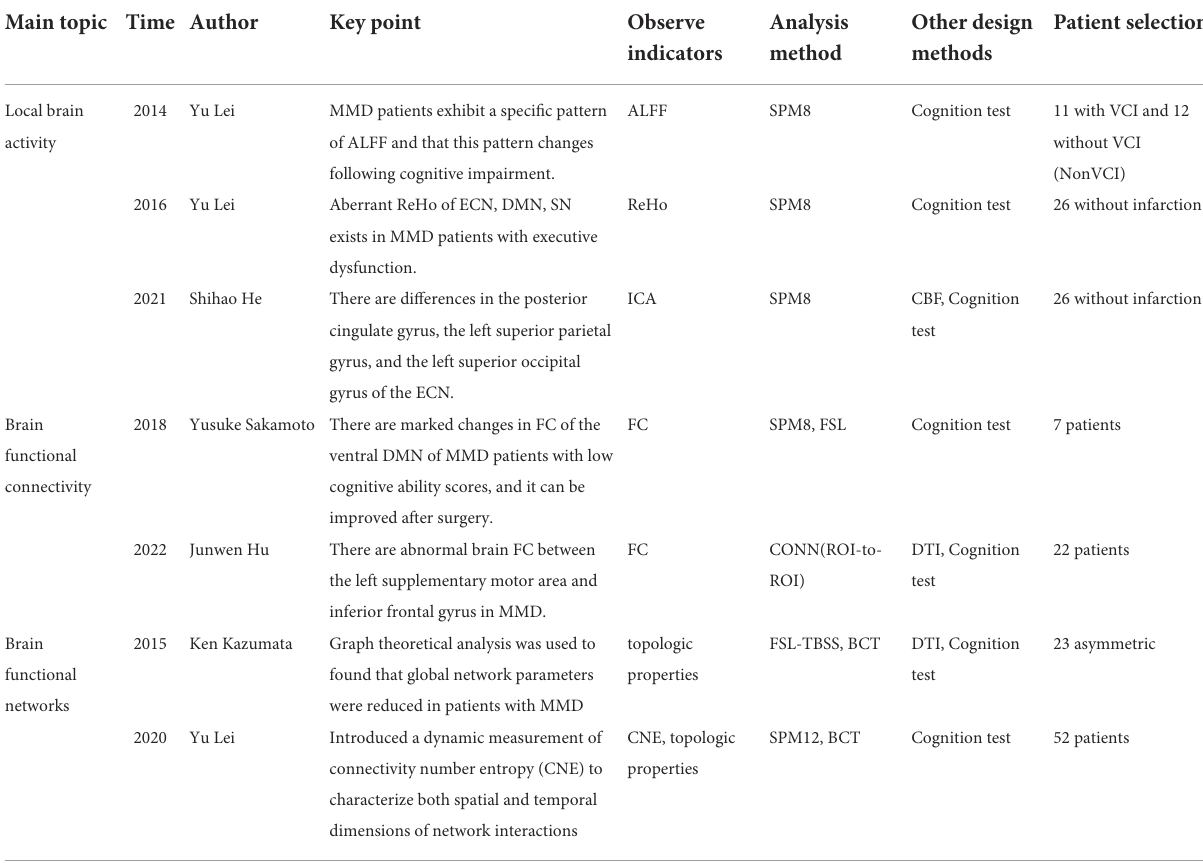
TABLE 2 Studies in recent years about rs-fMRI analysis of